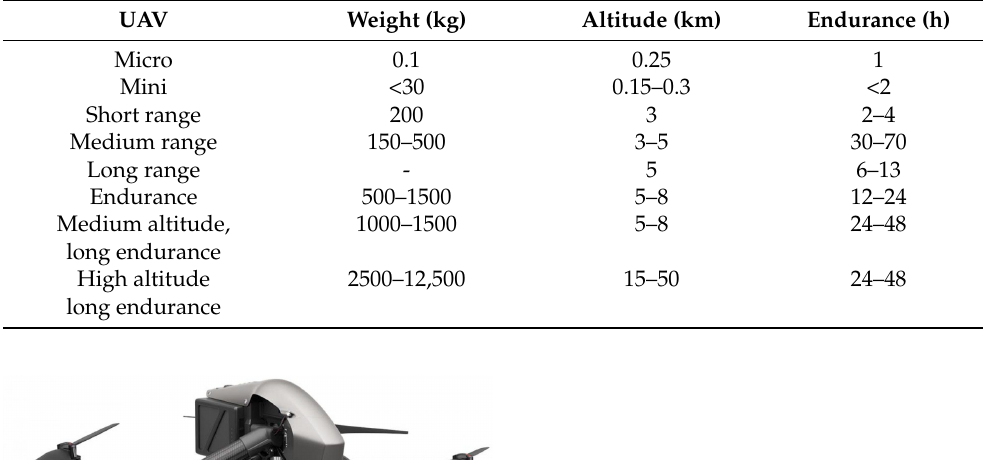
Table 1. Unmanned aerial vehicles (UAVs) classification. Adapted from the work in [9].